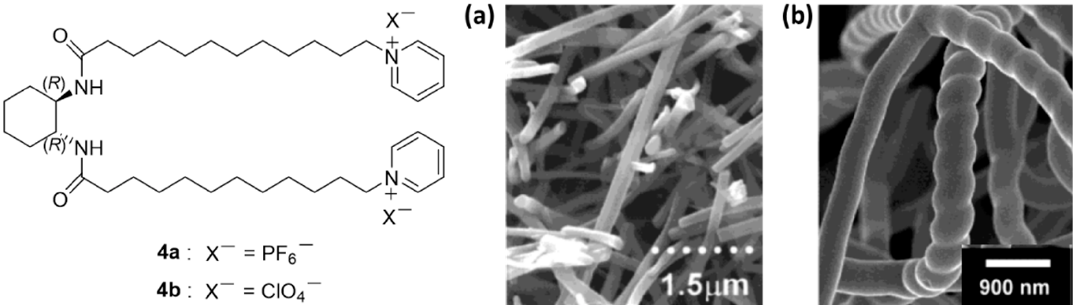
Figure 3. Structure of amphiphilic organogelators 4a and 4b and SEM images of ( a ) self-assembled 3a in ethanol; ( b ) tantalum oxide right-handed fibers obtained from 4b . Adapted with permission from ACS [28,29].